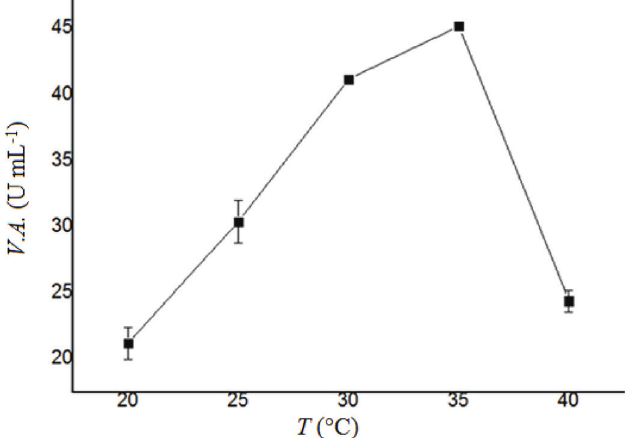
Fig. 1 – Effect of temperature on the enzyme activity (with pH 5, alginate concentration 20 g L –1 , rotation rate 120 rpm, and fermentation time 72 h)